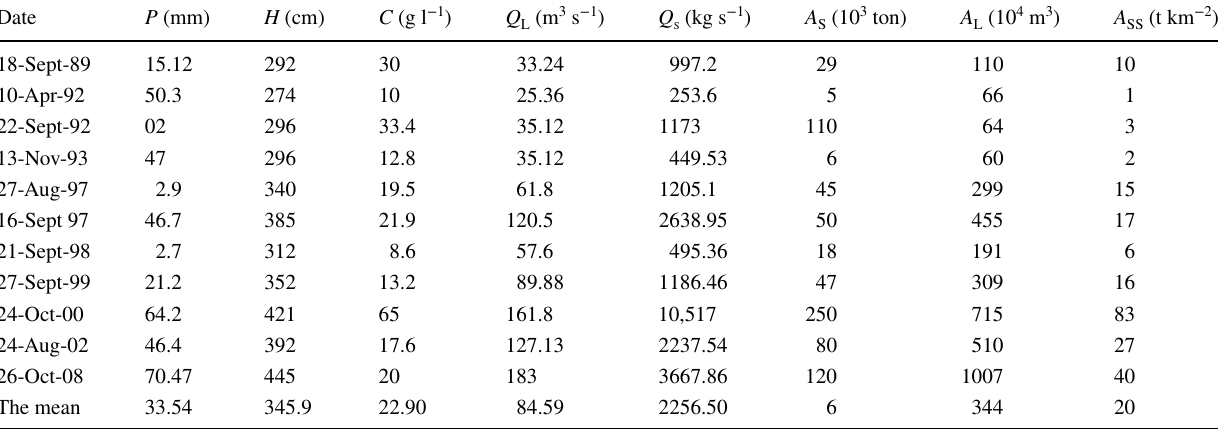
Table 1 The estimation of different solid–liquid contributions specific to the flood periods